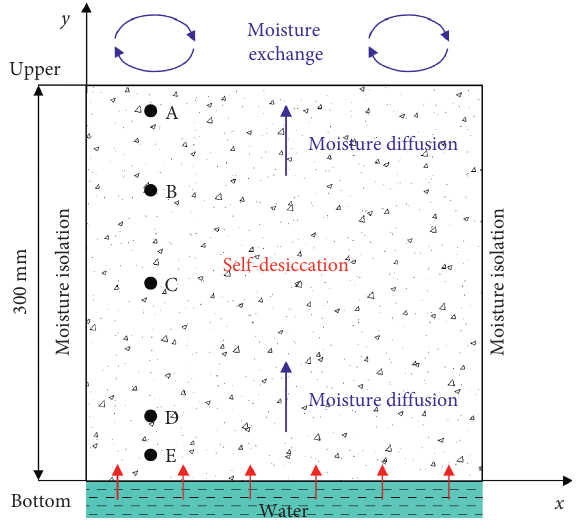
Figure 4: Early humidity field calculation model of concrete specimen ( w/c � 0.4).